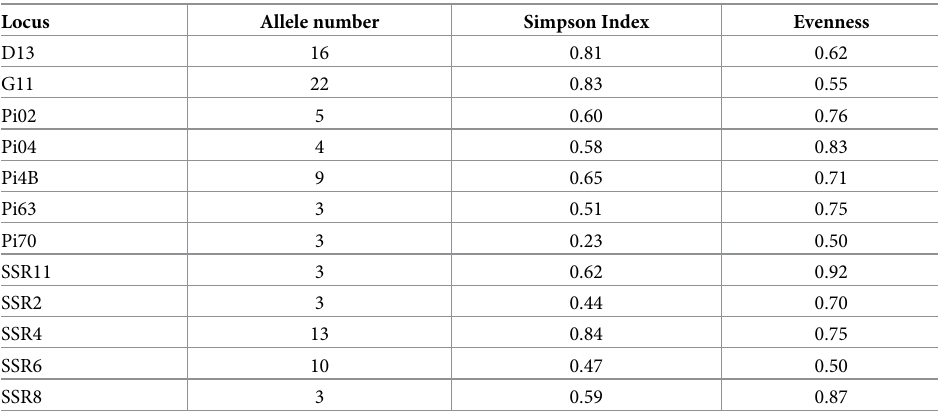
Table 2. Summary data for each SSR